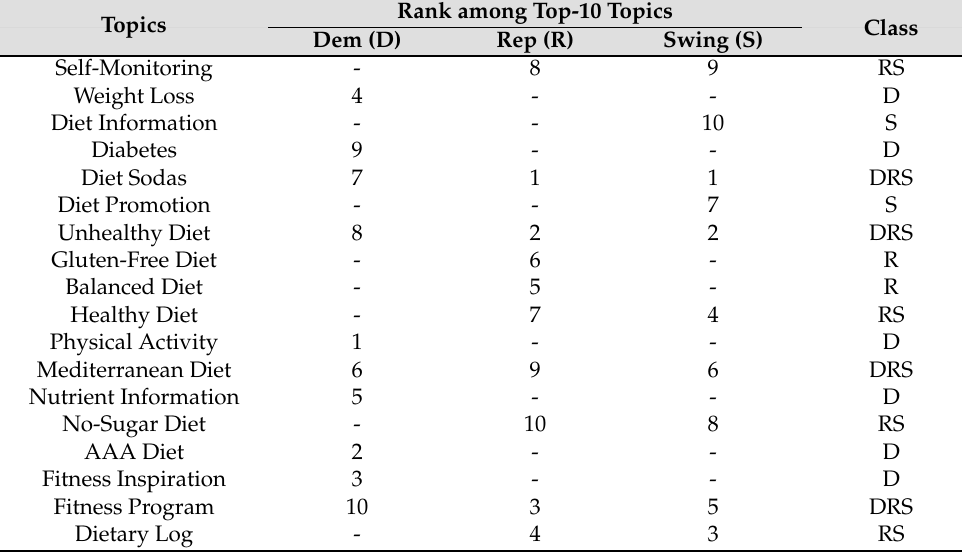
Rank among Top-10 Topics